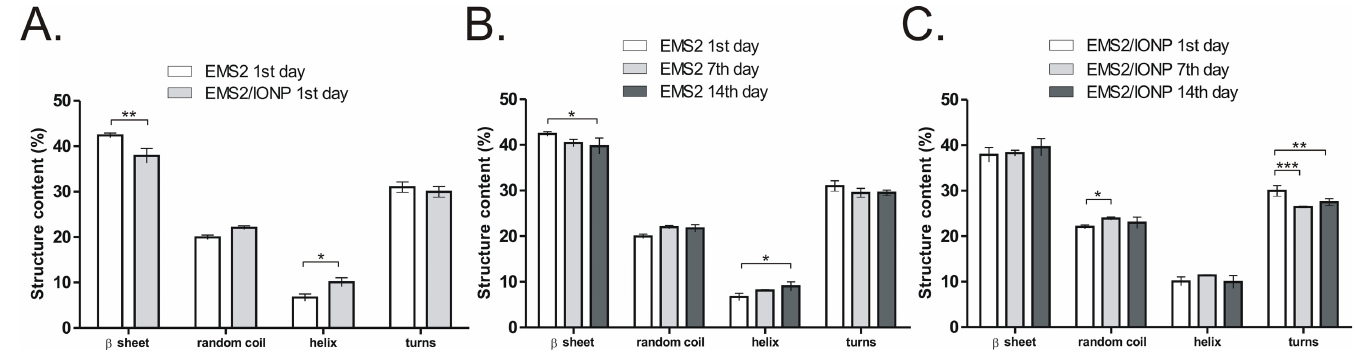
Fig 4. Secondary structure analysis of the EMS2 and EMS2/IONP spheres. A) The secondary structure composition of the EMS2 and EMS2/IONP spheres investigated on the 1 st day of storage. B, C) Analysis of the secondary structure composition of the (B) EMS2 and (C) EMS2/IONP spheres during storage on the 1 st , 7 th and 14 th day. The secondary structure content of both types of particles was calculated after Fourier self-deconvolution of the amide I region of the FTIR spectra. The mean and error bars indicating the standard deviations are shown. The experiment was repeated three times. � indicates statistical significance with: � p < 0.05; �� p < 0.01; ��� p <